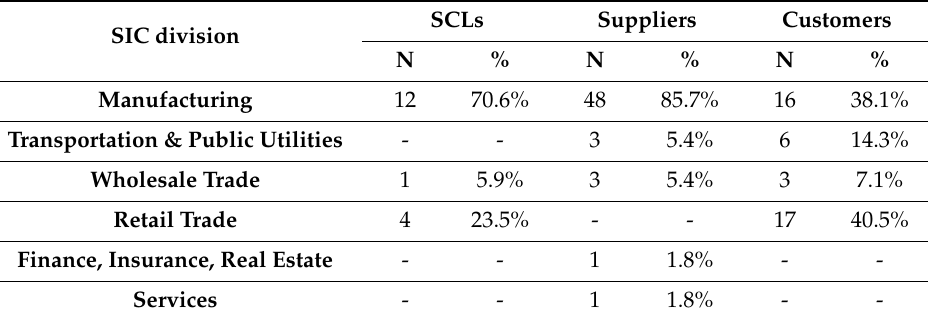
Table 3. Distribution of central sample firms in SIC divisions.